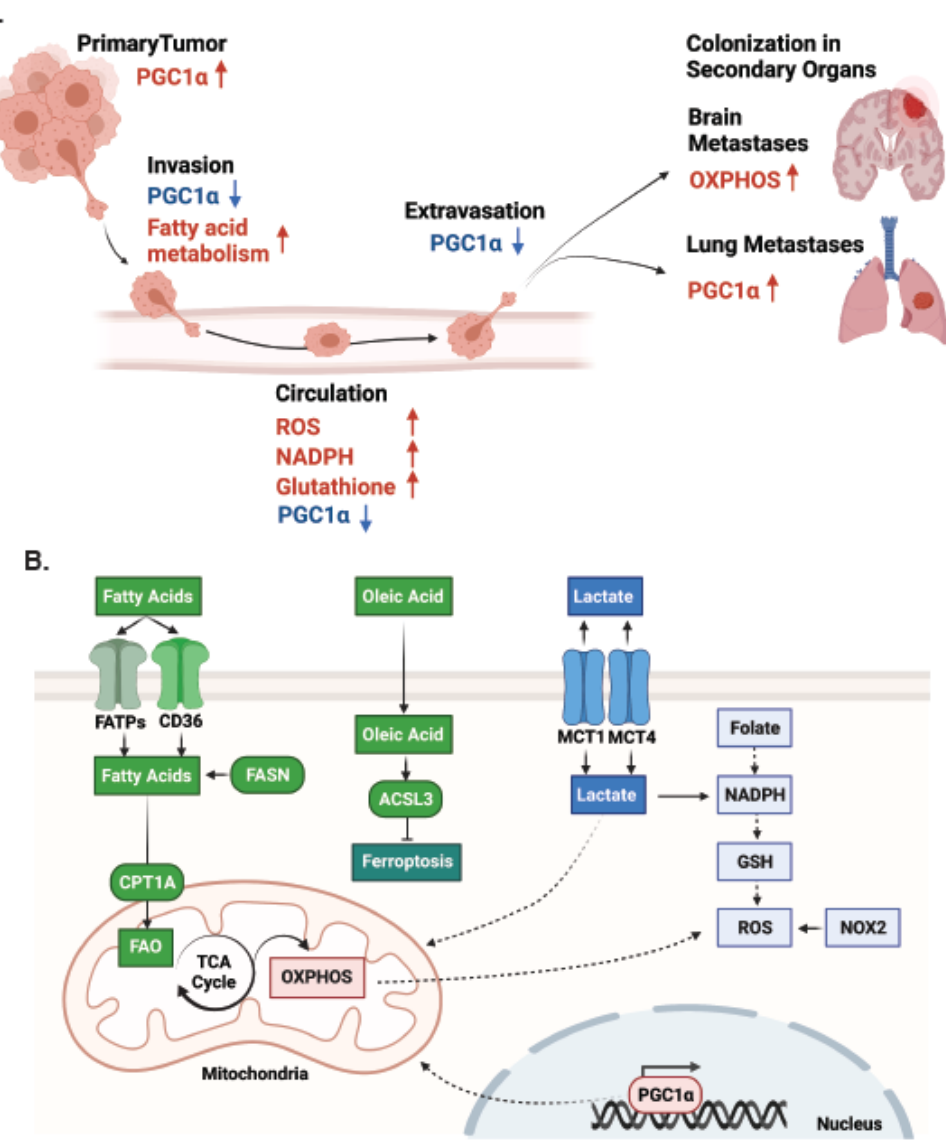
Figure 1. Metabolic plasticity during melanoma progression and metastasis. ( A ) Schematic of the major phases of the metastatic cascade and the corresponding metabolic pathways implicated in plasticity during melanoma metastasis (blue arrows = downregulation; red arrows = upregulation). ( B ) Schematic showing the major metabolic pathways directly implicated in metastasis. Upregulation of fatty acid transport via cluster of differentiation 36 (CD36) and fatty acid transporter proteins (FATPs) facilitates carnitine palmitoyltransferase 1A (CPT1A) ‐ dependent fatty acid oxidation (FAO) in the mitochondria. Uptake of lactate via monocarboxylate transporter 1/4 (MCT1/4) produces the antioxidant nicotinamide adenine dinucleotide phosphate (NADPH) and glutathione (GSH) to protect against reactive oxygen species (ROS). Oleic acid suppresses ferroptosis via acyl ‐ CoA synthetase long ‐ chain 3 (ACSL3). See text for details. PGC1 α = peroxisome proliferator ‐ activated receptor γ coactivator α ; FASN = fatty acid synthase; NOX2 = nitric oxide synthase (NOS) uncoupling, peroxisomes, (NADPH) Oxidase 2. Created with BioRender.com.